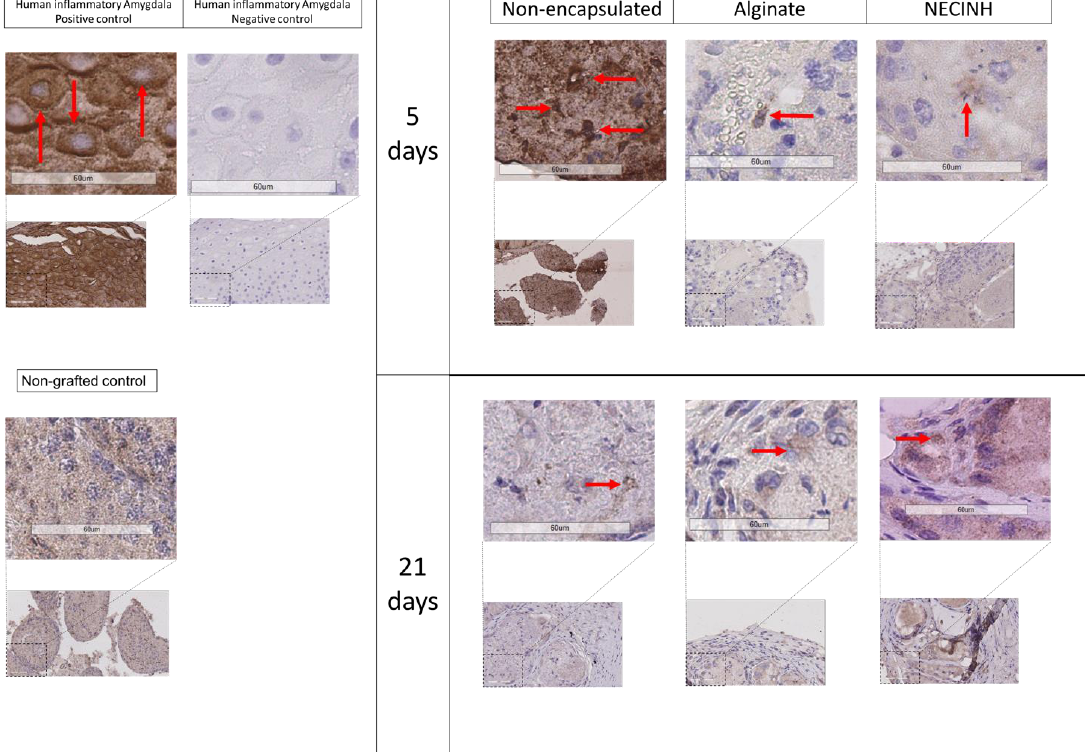
Figure 9. Impact of NECINH nanoparticles (NPs)-loaded hydrogel on lipid peroxidation in mice testicular tissue after autotransplantation for 5 and 21 days. Malondialdehyde (MDA)-positive cells were reduced on day 5 when encapsulation in alginate was performed, regardless of NPs supplementation. Positive cells are highlighted by red arrows.